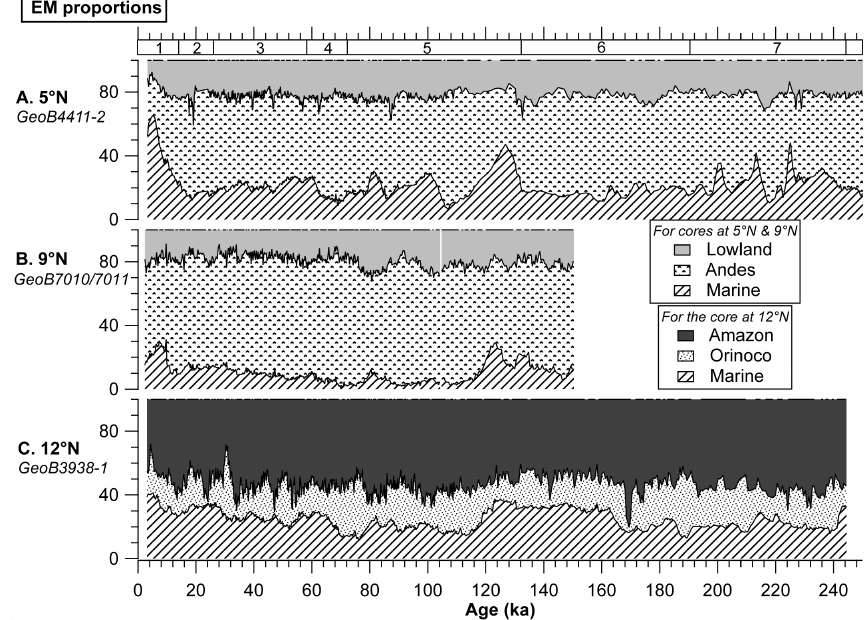
Fig. 5. Variations in the cumulative percentages of terrigenous and marine biogenic endmembers (EM) obtained in sites at (A) 5 ◦ N: GeoB4411-2, (B) 9 ◦ N: GeoB7010-2 (0–104ka), GeoB7011-1 (105–150ka) and (C) 12 ◦ N: GeoB3938-1 (see legend for filling patterns). The definition of endmembers is summarized in Table S4 in the Supplement. Marine isotope stages are indicated at the top of (A)